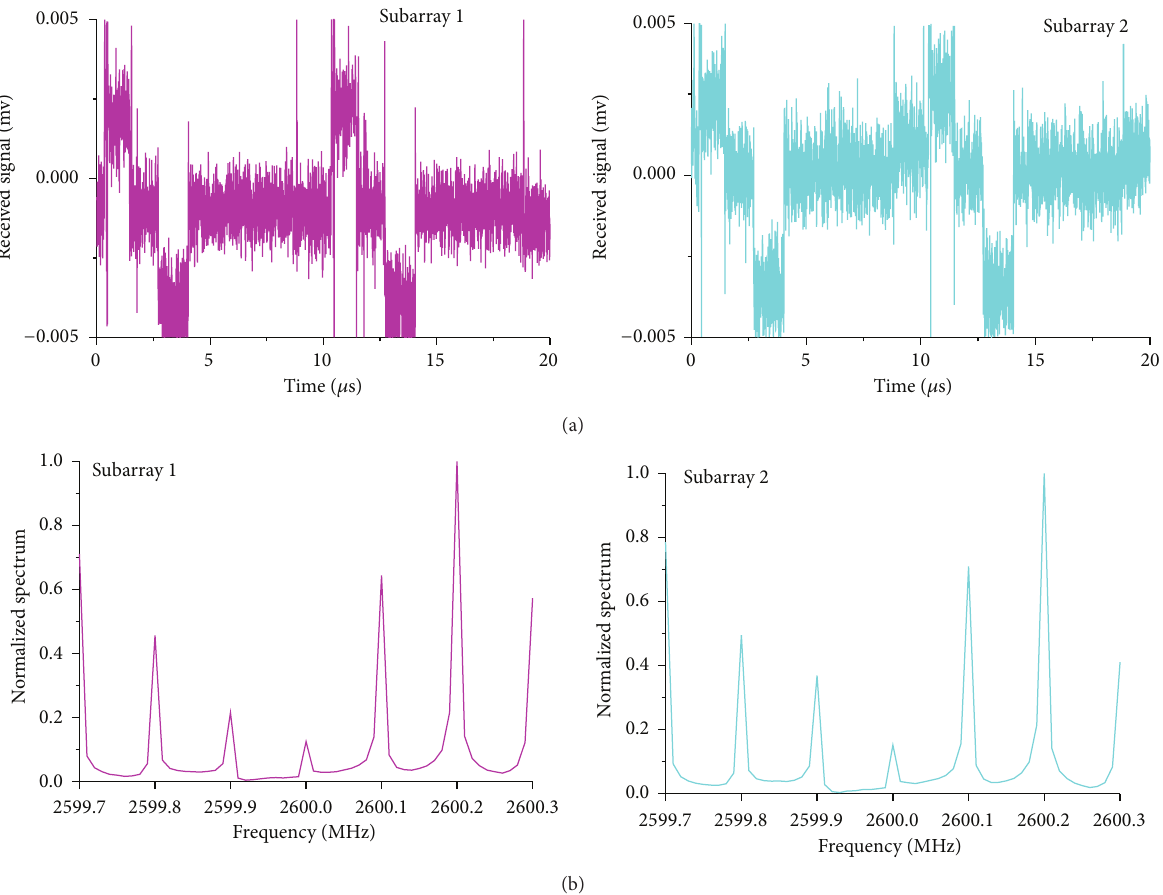
Figure 14: The procedure to determine the pair of sum-difference patterns that has the maximum amplitude response and should be used for angle measurement. (a) The waveforms of signals received by the two subarrays at 𝜃 = 30 ∘ . (b) The spectra of received signals received at 𝜃 = 30 ∘ , which are obtained by FFT performed in PC.